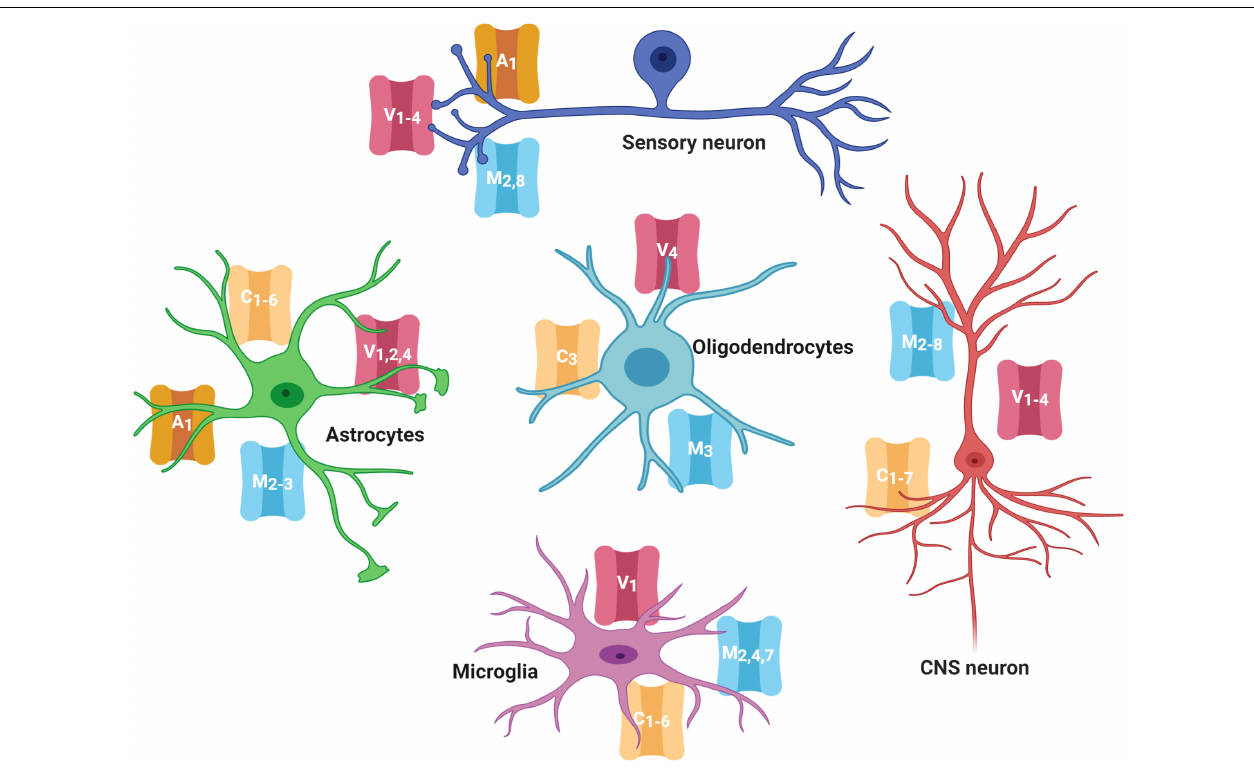
FIGURE 1 | TRP channels expressed in the nervous system cells. Several members of the TRPC, TRPV, TRPM, and TRPA families are highly expressed in cells of the central and peripheral nervous system (neurons, astrocytes, oligodendrocytes, and microglia). TRP families are represented by capital letters as follow, C, TRPC; M, TRPM; V, TRPV; A, TRPA. Numbers indicates specific members of each